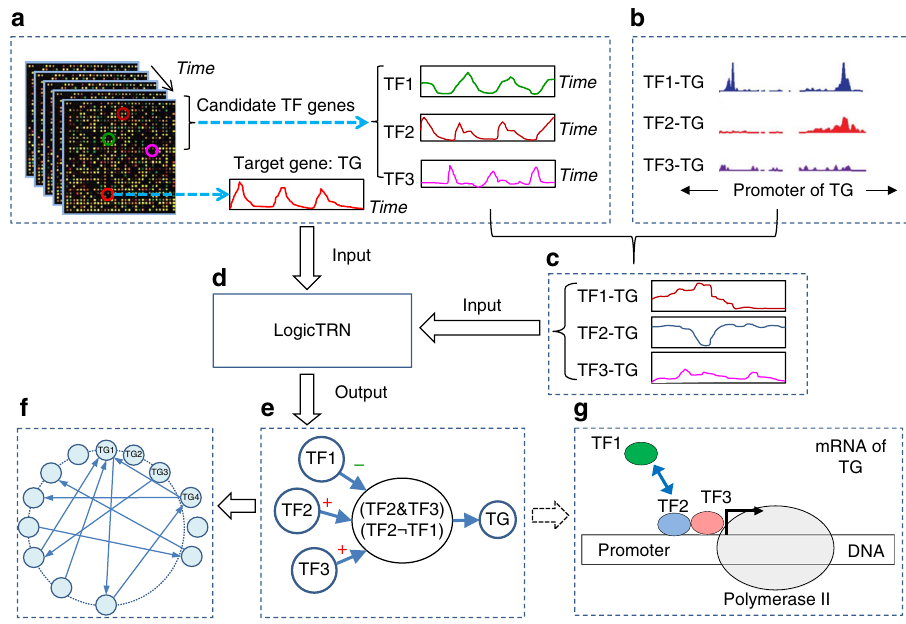
Fig. 1 The computational framework of LogicTRN. a Time-series gene expression data. For a given target gene G1, we assume three TFs, TF1, TF2, and TF3, can bind to its promoter. b TF-DNA-binding signals from ChIP-seq measurement or TF-binding motifs on target gene promoters. c Calculation of TF-DNA- binding occupancy over time. d Construction of model equations using the data from a , c . e Identi fi cation of the regulatory logic for the gene TG. f Reconstruction of the TRN consisting of TF regulatory logics and target genes. g Describing transcriptional gene regulatory